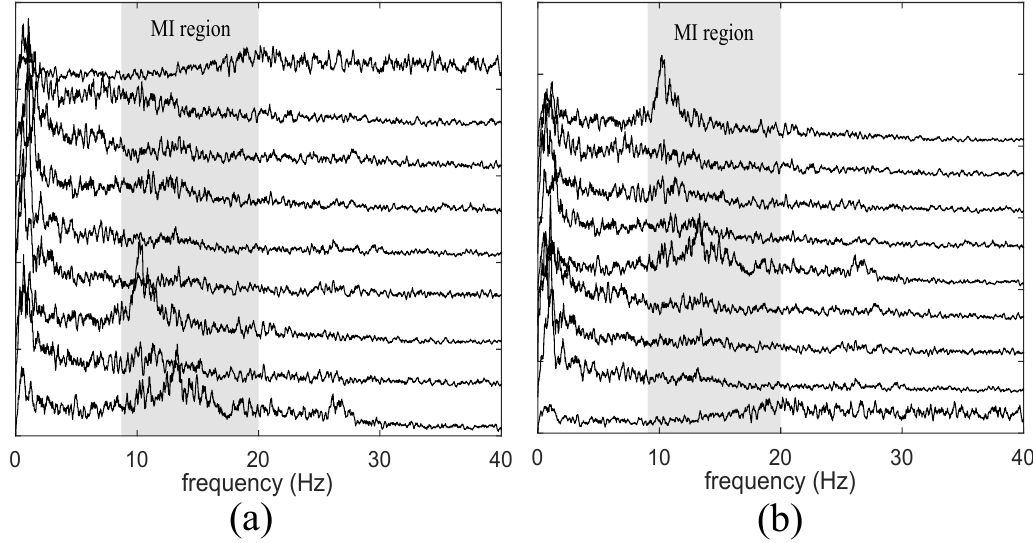
Figure 6. Analysis spectral components: ( a ) before sort; ( b ) after sort. The components with more MRIC frequencies are placed at the top after